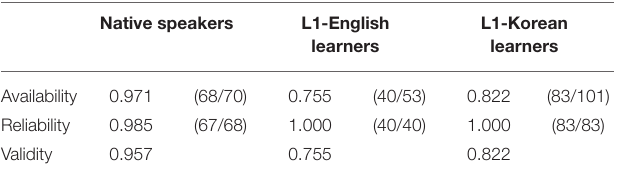
TABLE 11 | Availability, reliability, and validity of word-order, case-marking, and animacy cues in sentences with an overt subject and object. Native speakers